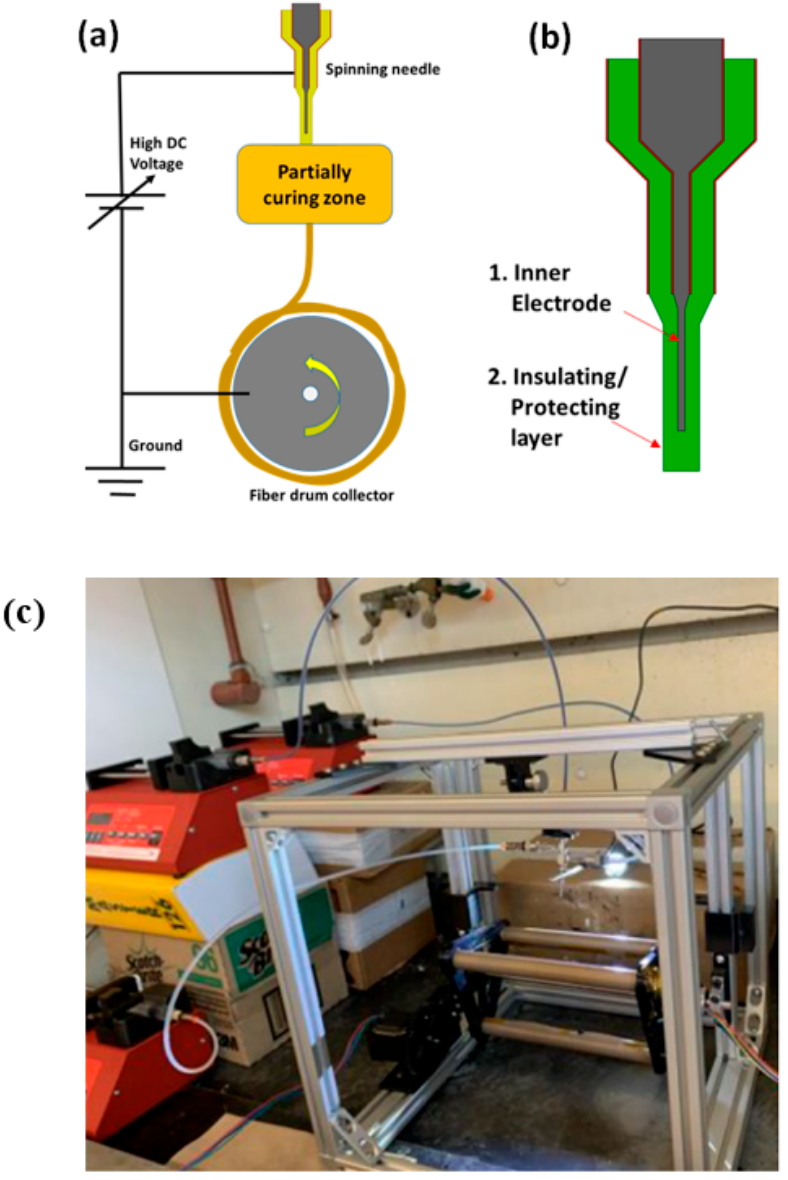
Figure 2. ( a ) Schematic of electrospinning setup with the drum operating at speeds of 55–80 rpm, ( b ) the nozzle, and ( c ) the assembled electrospinning